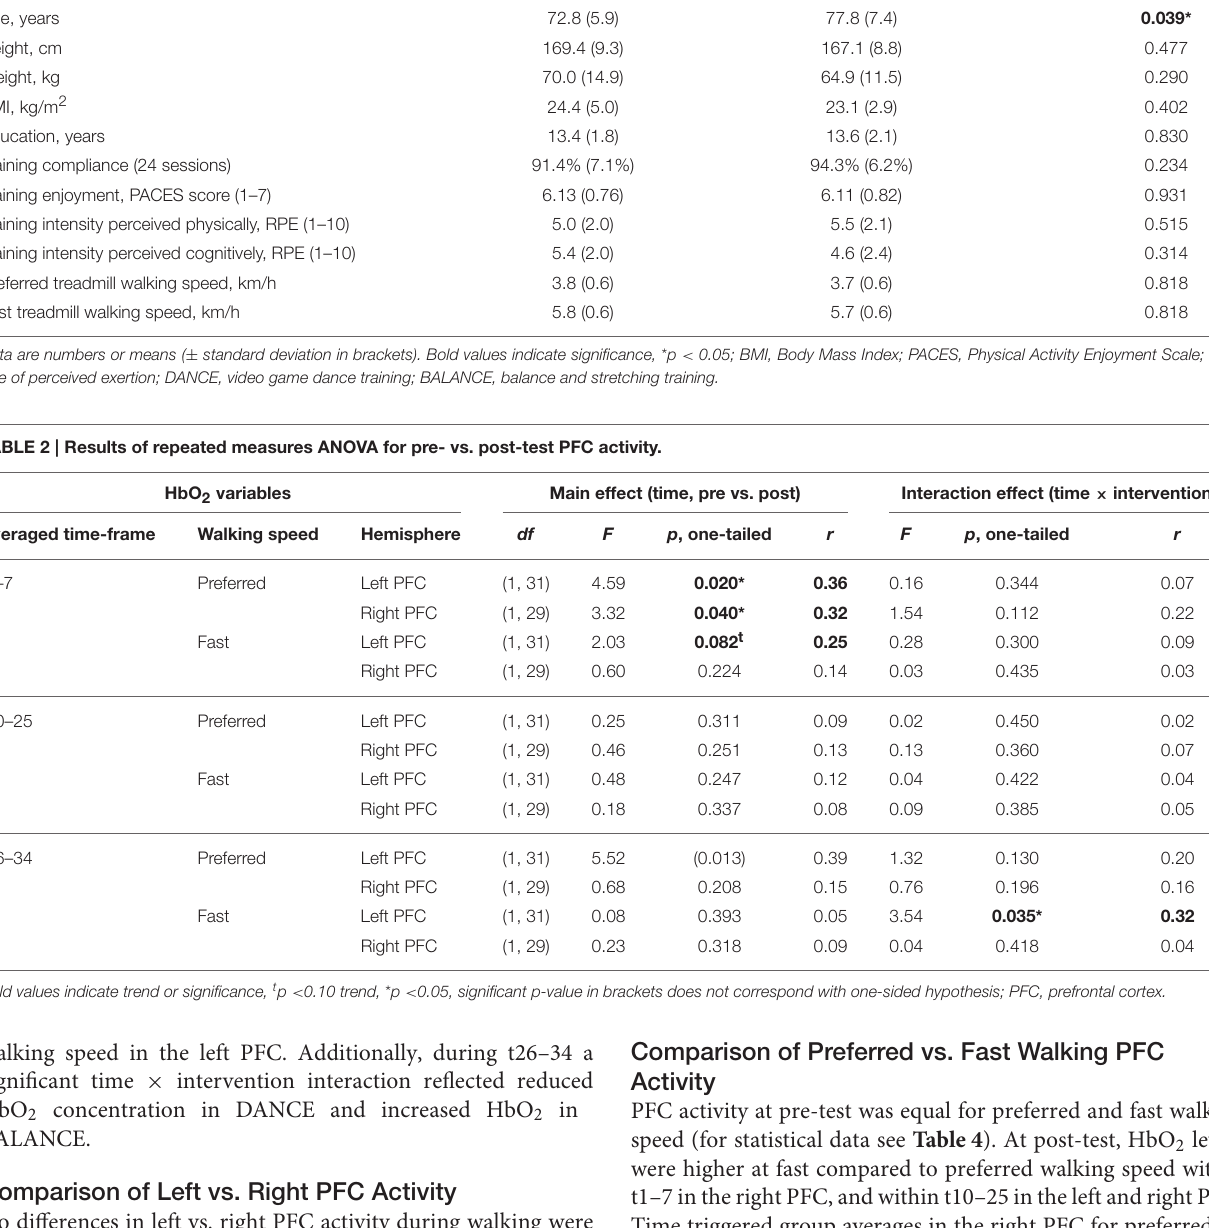
changes in PFC activity and cognitive performance.